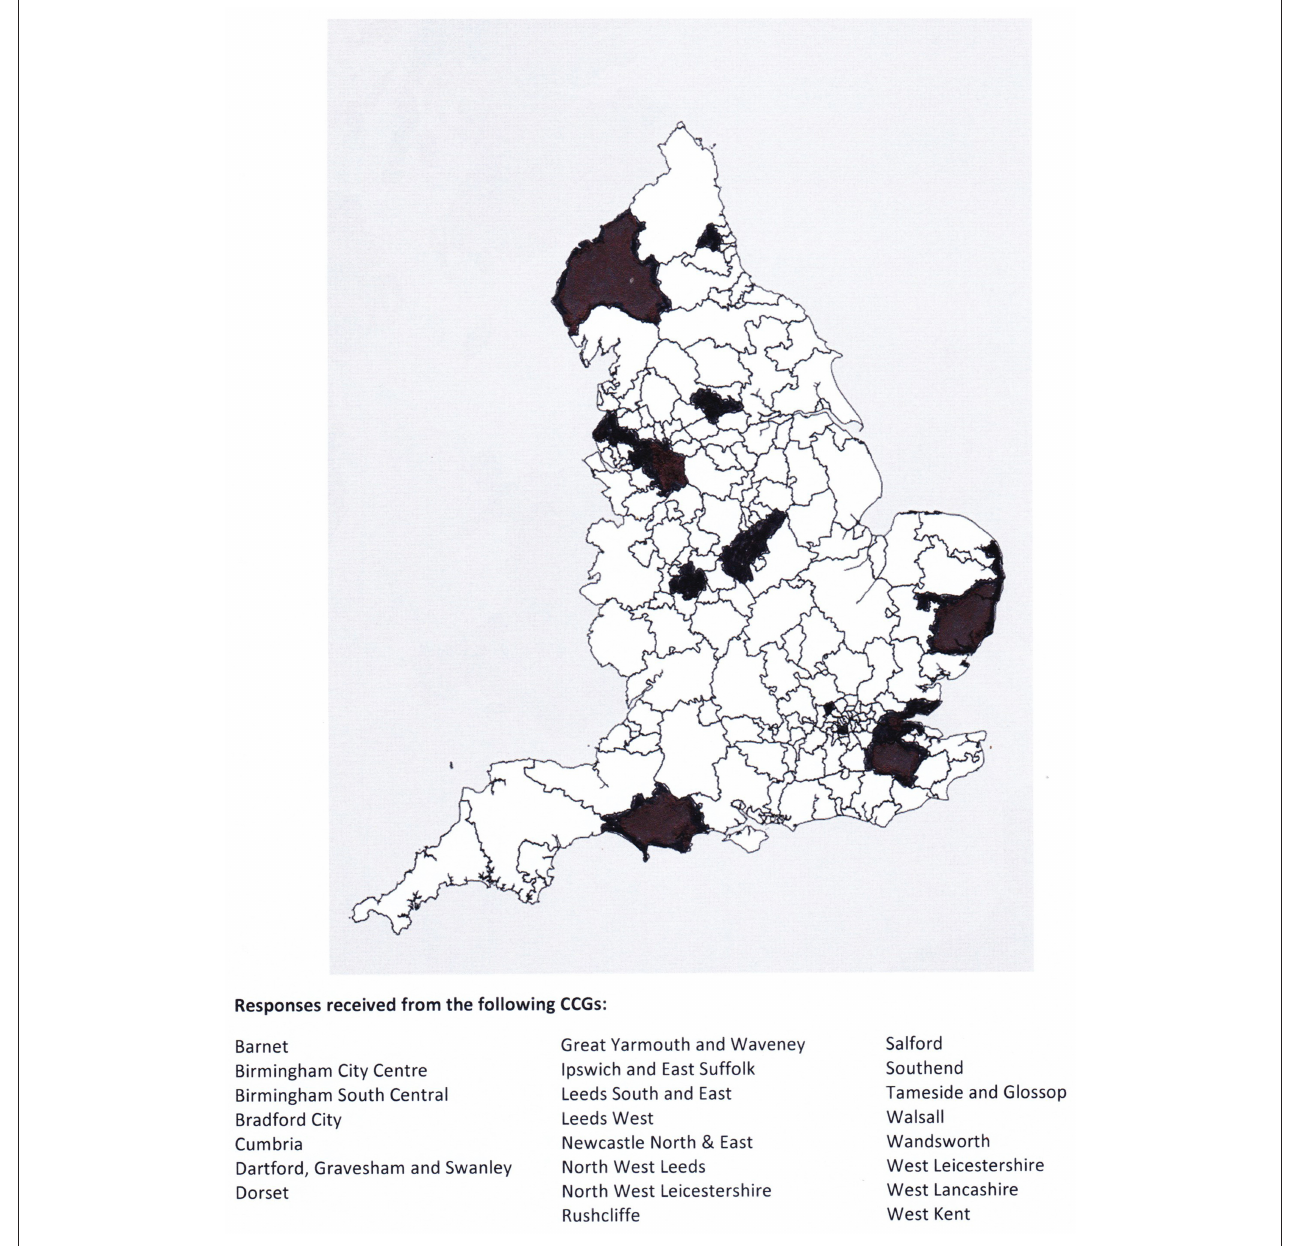
FIGURE 1 | CCG areas that responded to the